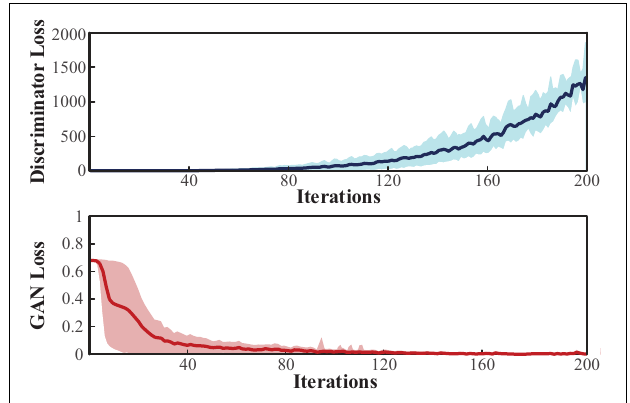
FIGURE 18 | Training loss of the Discriminator and GAN.